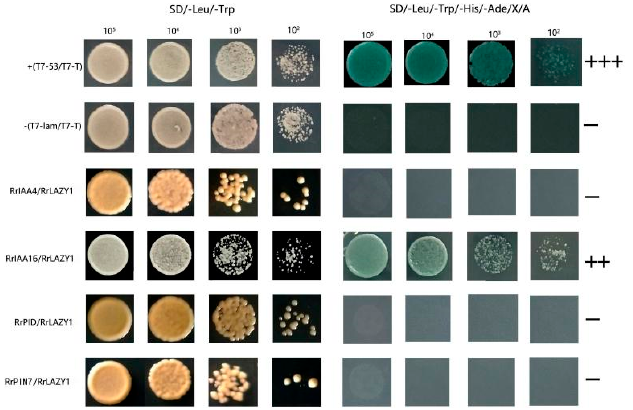
Figure 5. Expression analysis of auxin-related genes in RrLAZY1 transgenic Arabidopsis lines and the WT. WT, wild-type Arabidopsis. Different lowercase letters indicate significant differences at p < 0.05.